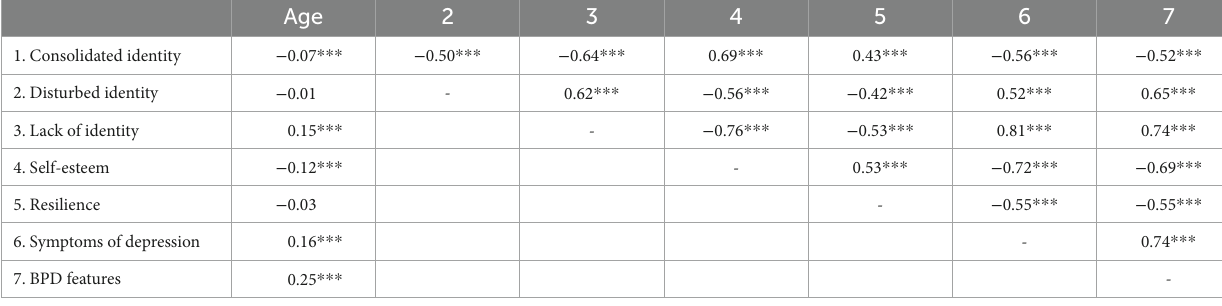
TABLE 2 Zero-order Pearson correlations between study variables and age, and among study variables at Time 1.